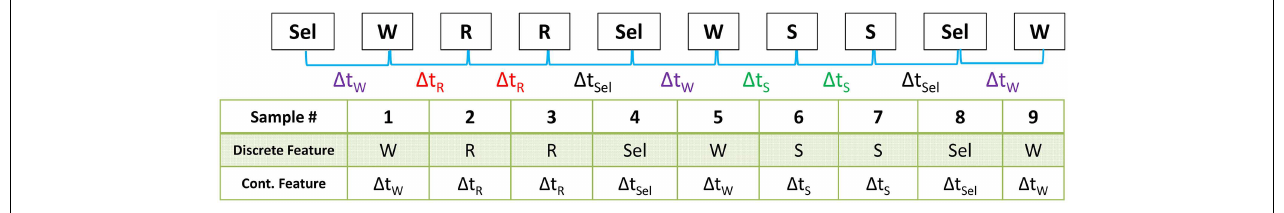
The row of the table labeled “Categorical Feature” contains the sequence of behavior codes derived from the raw data, and the bottom row of the table contains the corresponding time delta between the previous and current activity. This process created the mixed categorical-continuous time-series dataset used in this